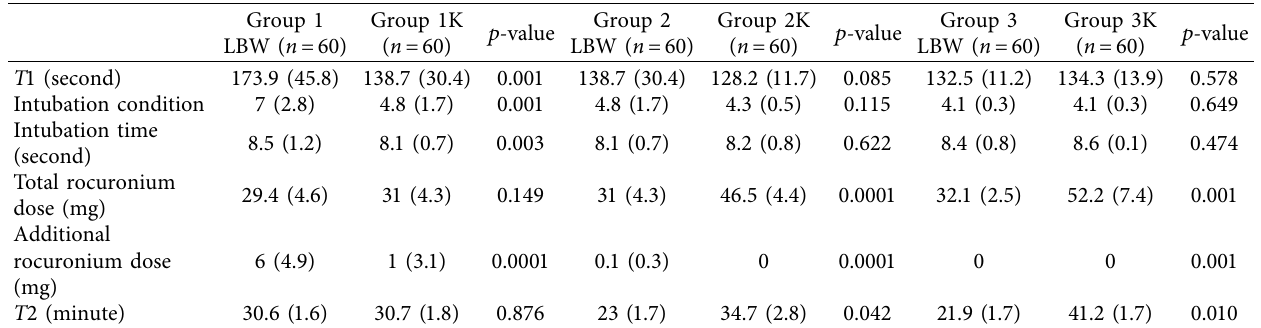
Table 3: Comparison of the groups in terms of intubation conditions and duration of rocuronium